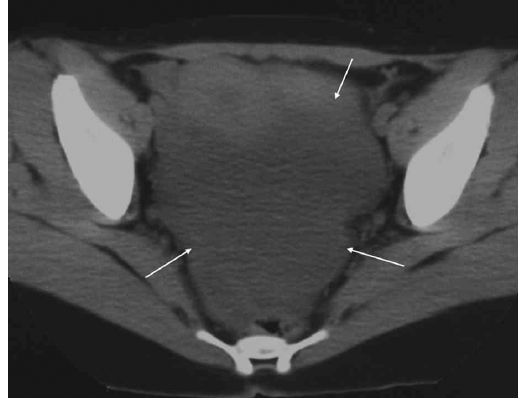
Figure 3 - Computed tomography with no intravenous contrast agent revealed that there was no calcification within the mass (arrows)